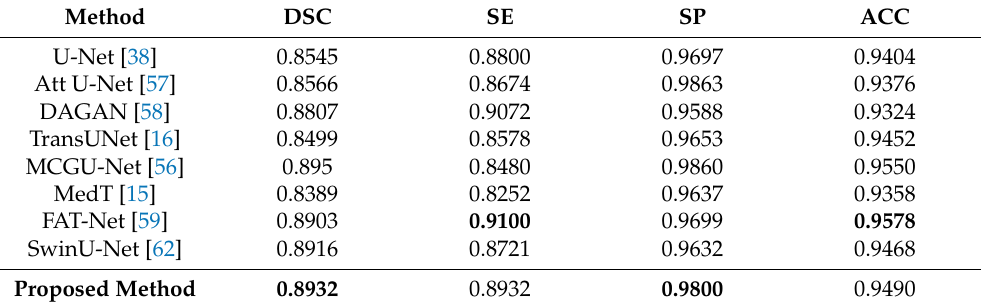
Table 2. Comparison results of the proposed method against the SOTA approaches on the ISIC 2018